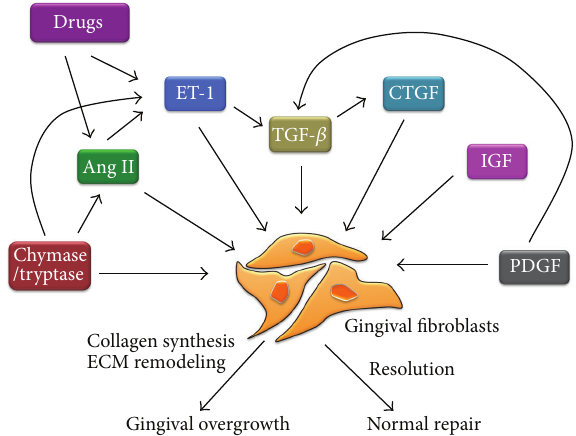
Figure 1: Schematic diagram of interplay among profibrotic medi- ators. These proteins promote fibroblast activation and gingival fibrosis. Ang II: angiotensin II; CTGF: connective tissue growth factor; ET: endothelin; IGF: insulin-like growth factor; PDGF: platelet-derived growth factor; TGF: transforming growth factor; ECM: extracellular